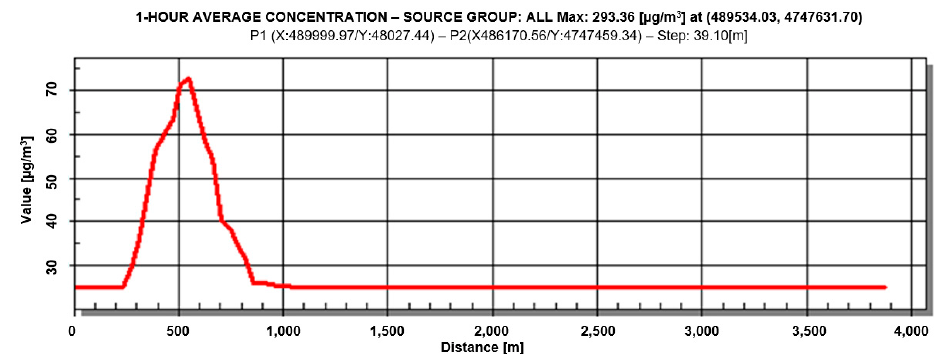
Figure 7. Cross section of the airborne pollution distribution in the east direction.